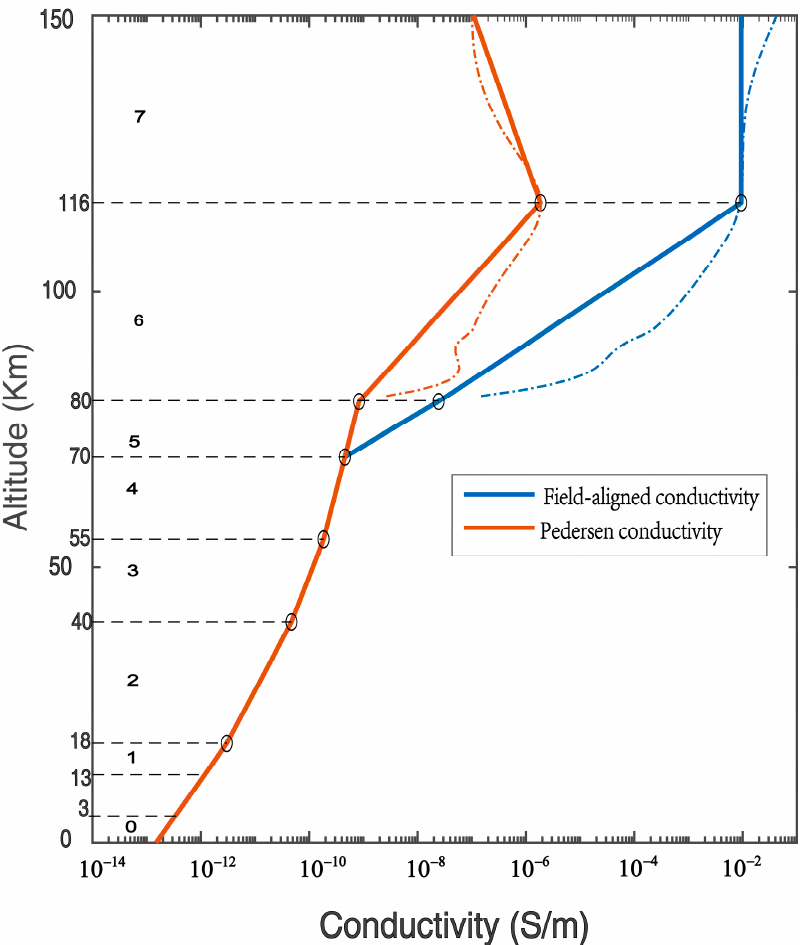
Figure 1. Conductivity profile in the atmosphere. The dotted line is the ionospheric conductivity